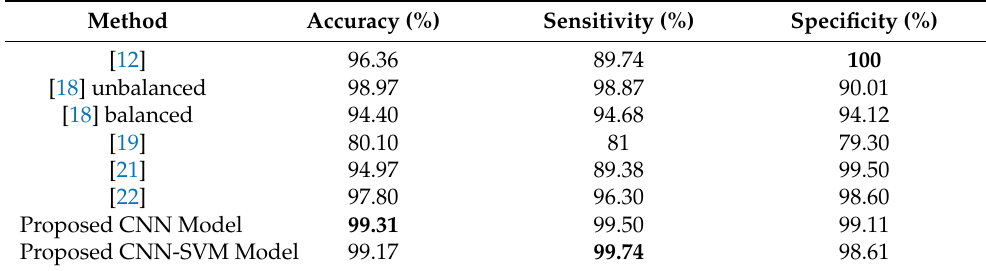
Table 5. Evaluation metrics of the different methods found in the